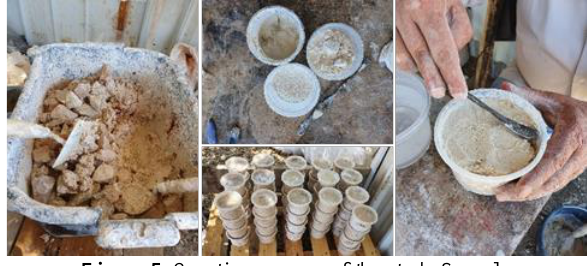
Figure 5. Creation process of the study Samples